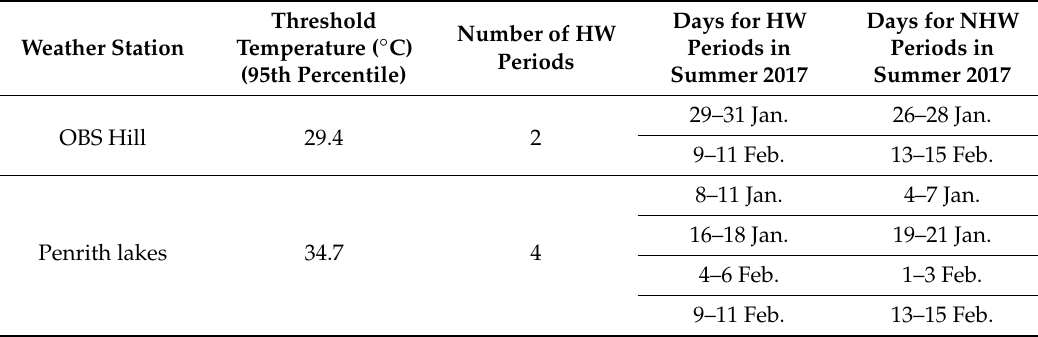
Table 2. Total Number of HW Periods and their duration in Summer 2017 (with 95th Percentile and three consecutive days